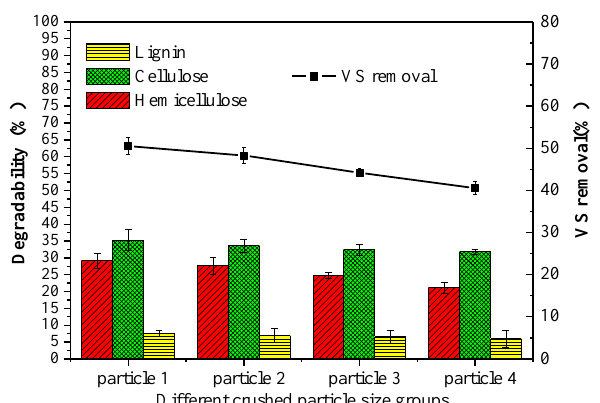
Figure 5. Degradability of lignocellulose after aerobic hydrolysis and acidification and vs. removal after AAD of different particle sizes. Notes: particle 1–4 represent sieve size diameter of 1, 3, 5, 7 mm group, respectively.